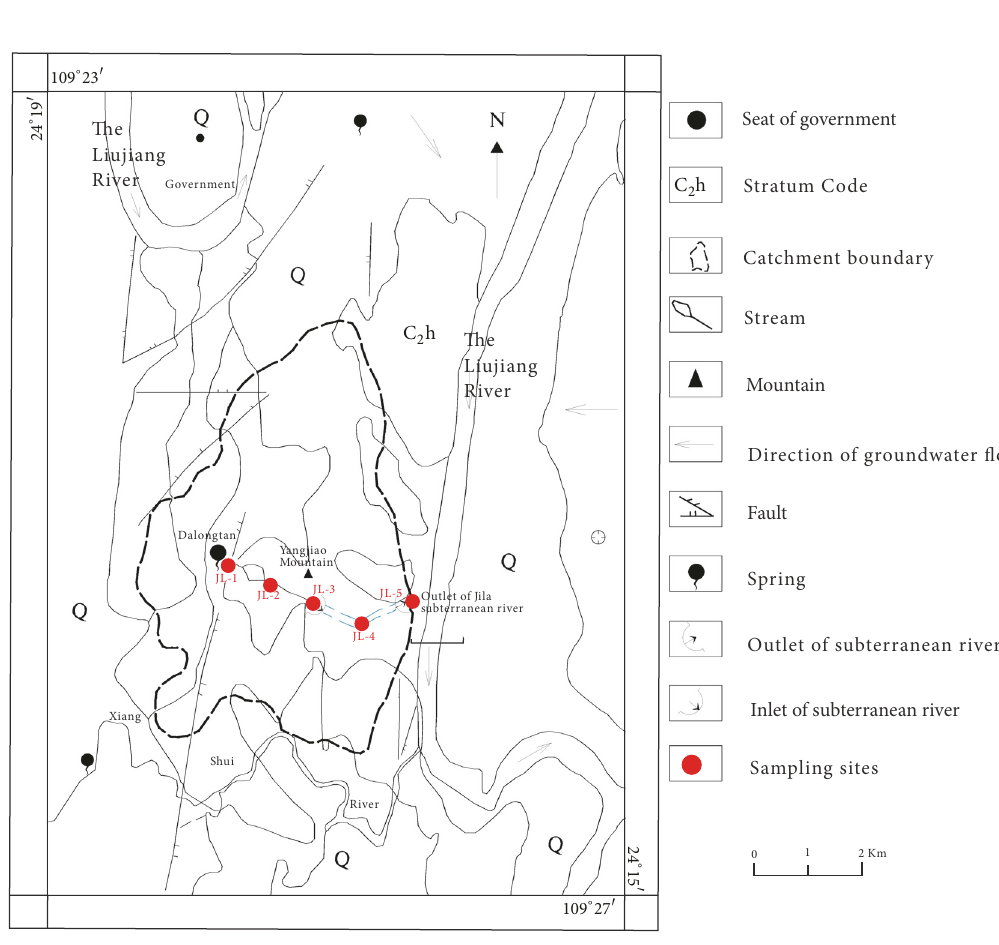
Figure 2: Hydrogeological map and location of sampling sites in the Jila subterranean river basin